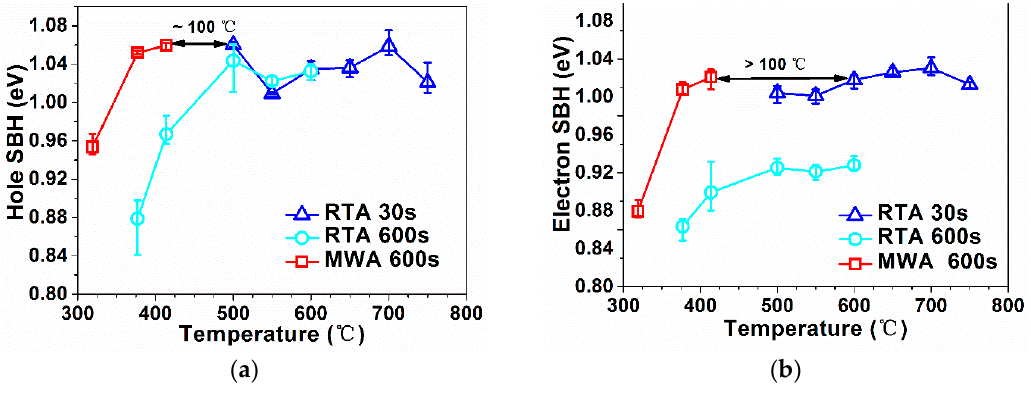
Figure 5. Annealing temperature versus ( a ) the hole Schottky barrier height (SBH) ( ϕ bp ) on the p-type substrate; and ( b ) the electron SBH ( ϕ bn ) on the n-type substrate. Table 2. Effective SBH and ideality factor of each annealing condition.